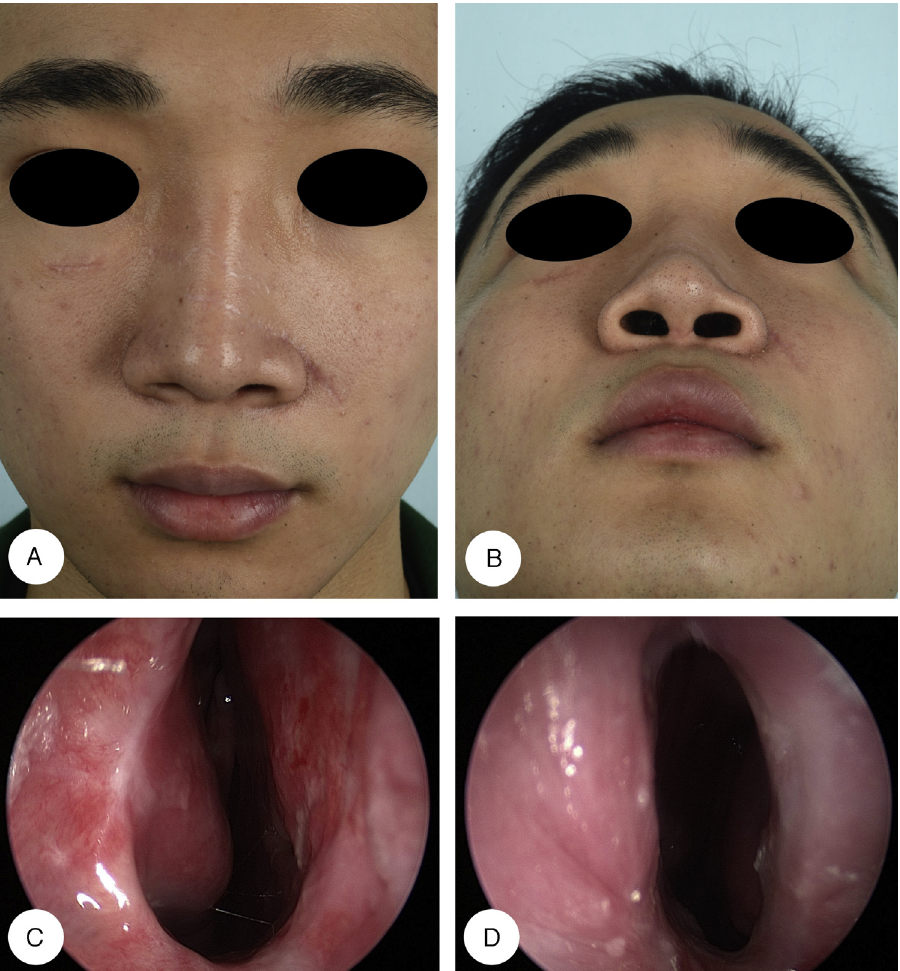
Postoperative profiles and endoscopic findings. Frontal (A) and basal (B) views show excellent cosmetic outcome. Nasal endoscopy at postoperative six months shows the right (C) and left (D) nasal vestibules are patent, with no evidence of